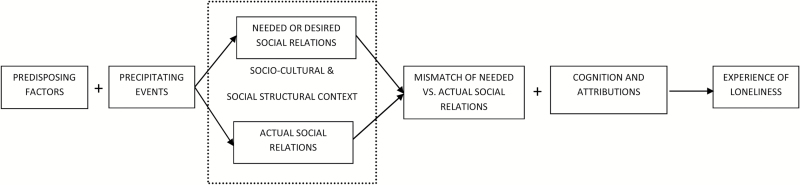
A discrepancy model of loneliness adapted from Perlman and Peplau (1998).